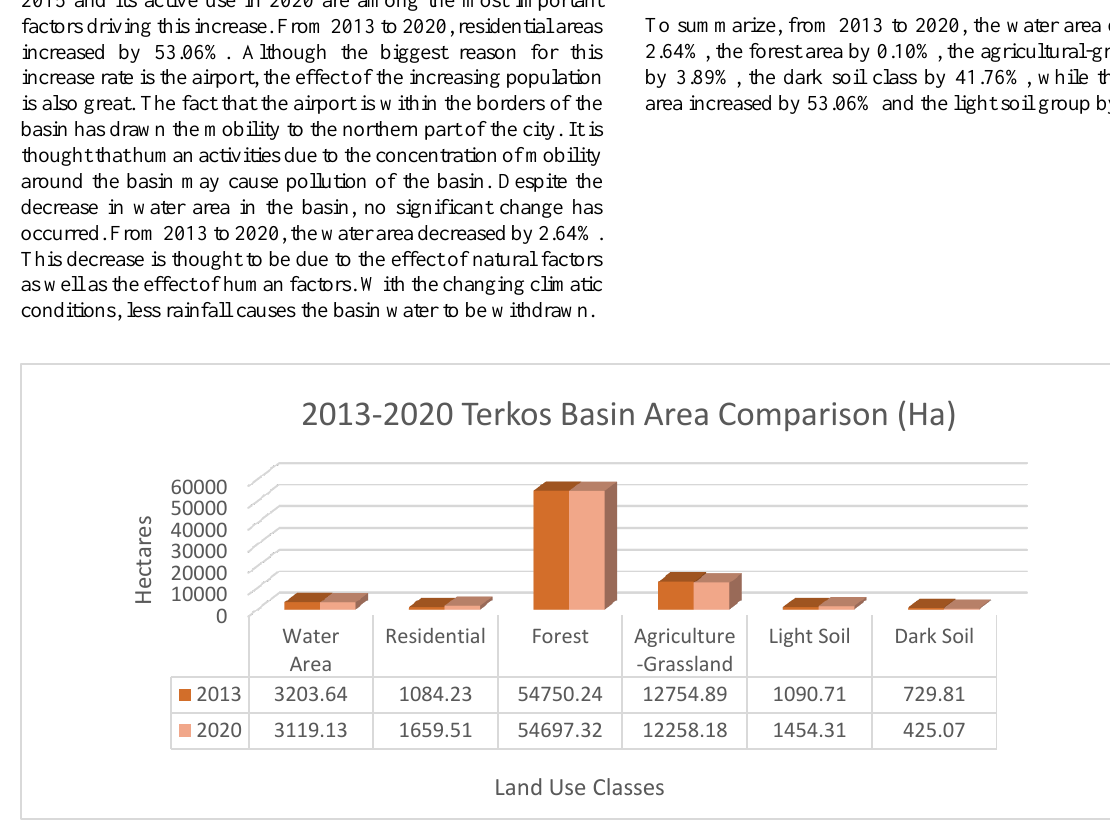
Figure 5. 2013-2020 Area